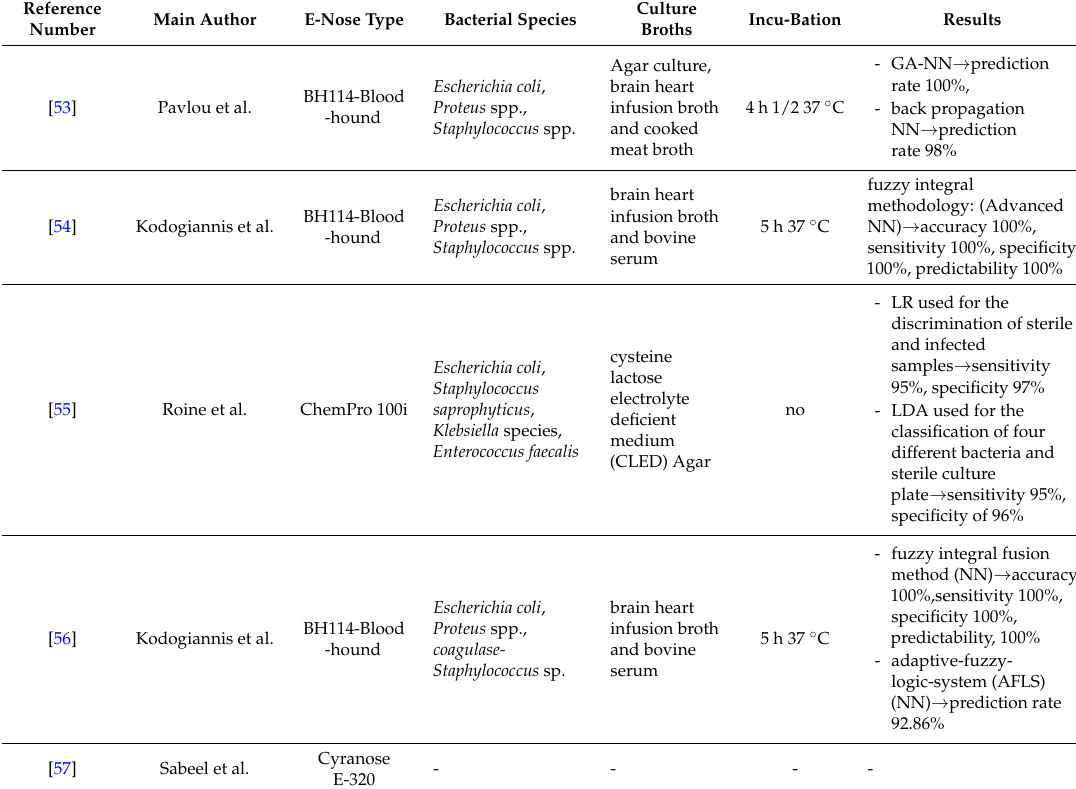
Table 3. Scheme of the studies regarding the detection/identification of